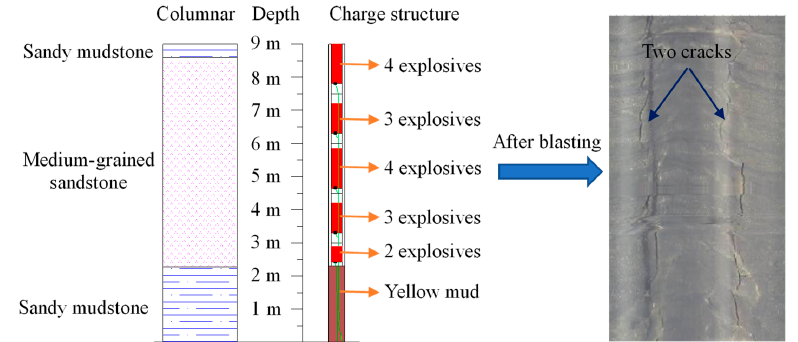
17 of 21 Figure 16. Stress cloud map of cumulative blasting. ( a ) t = 3.922 μ s; ( b ) t = 9.4889 μ s; ( c ) t = 33.998 μ s; ( d ) t = 122.36 μ s. Figure 17. Damage variation of cumulative blasting. ( a ) t = 18.469 μ s; ( b ) t = 22.491 μ s; ( c ) t = 33.998 μ s; ( d ) t = 108.42 μ s. 5.3.2. Application Effects in the Field Experiment Directional presplit cumulative blasting can directly affect the application effects of GERRC. The blasting test must be carried out in advance to determine the final charge structure. First, a single hole blasting test is carried out according to the above design parameters to determine the initial charge structure, and then continuous blasting is carried out, and the charge structure is adjusted in time by observing the crack in the hole after blasting. The higher the crack rate in the hole is, the better the effect of presplitting, and a reasonable charge structure occurs when the crack rate is more than 70% in the hole. In the field test, the size of the emulsion explosive is φ 27 × 300 mm, and each weight is 200 g.